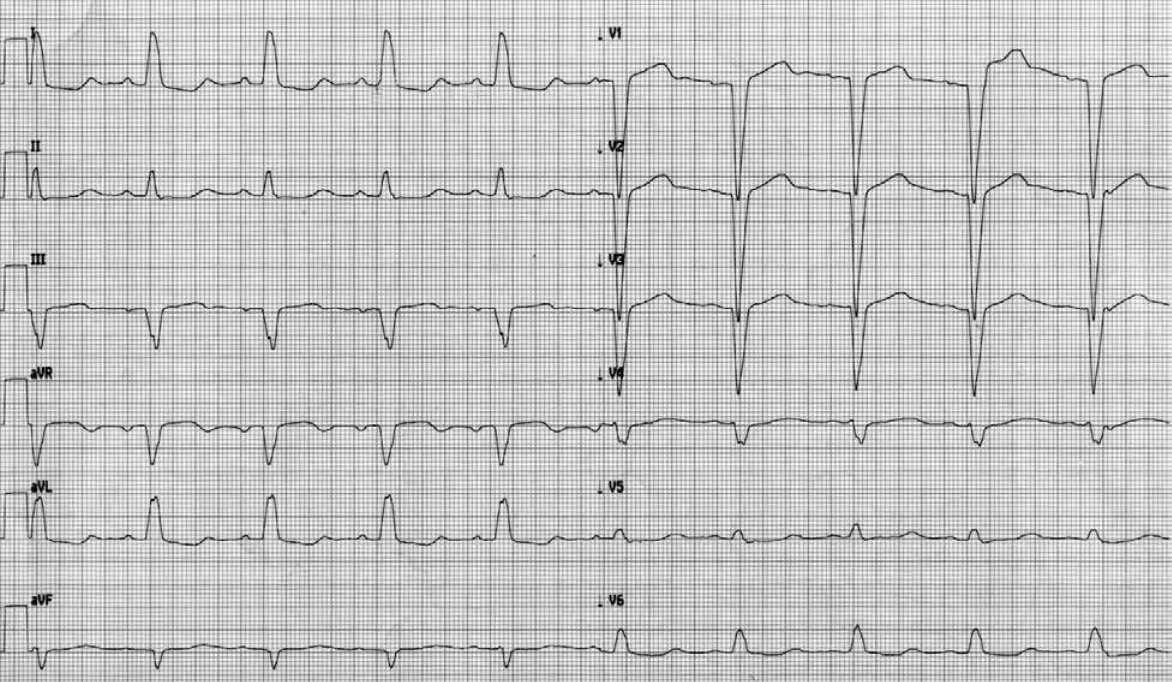
Figure 1: Internal electrocardiogram retrieved from ICD memory showing one of the TdP episodes. Report of the number of the TdP and VF episodes.